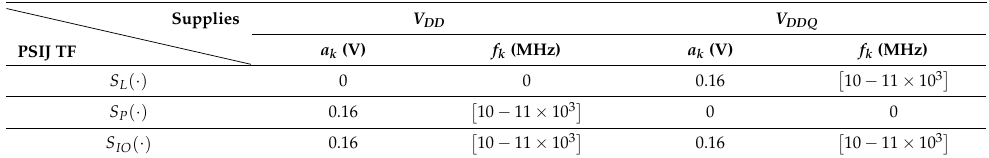
Figure 9. PSIJ experimental and theoretical TF variations due to the separate and the combined impacts of the supply voltage variations of the driver’s IO stages as a L = a P = 160 mV. Table 6. Experimental settings of the frequency sensitivity of the PSIJ TF of the driver’s IO stages of the results shown in Figure